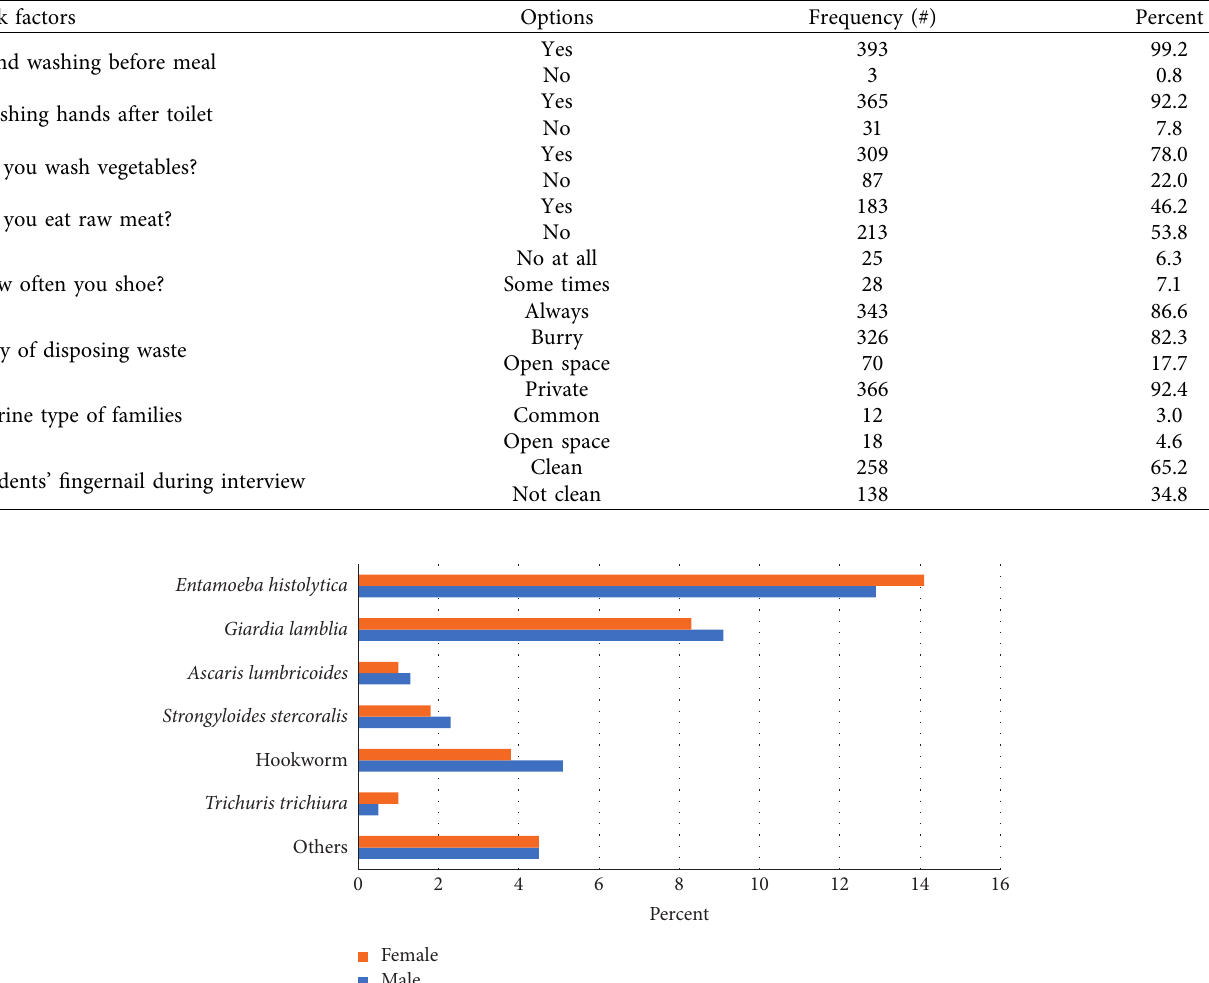
Table 1: Behavioral risk factors associated with intestinal parasitic infections.